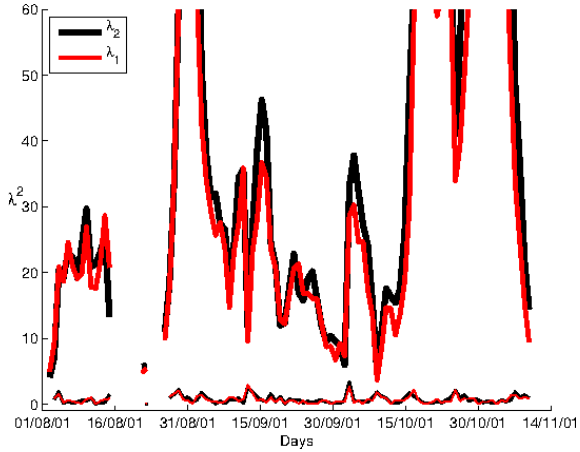
Fig. 8. Time evolution of the strength of the hyperbolicity λ 2 (thick lines), and its rate of change λ 0 tations were made for the evolution of the LCBph 2001